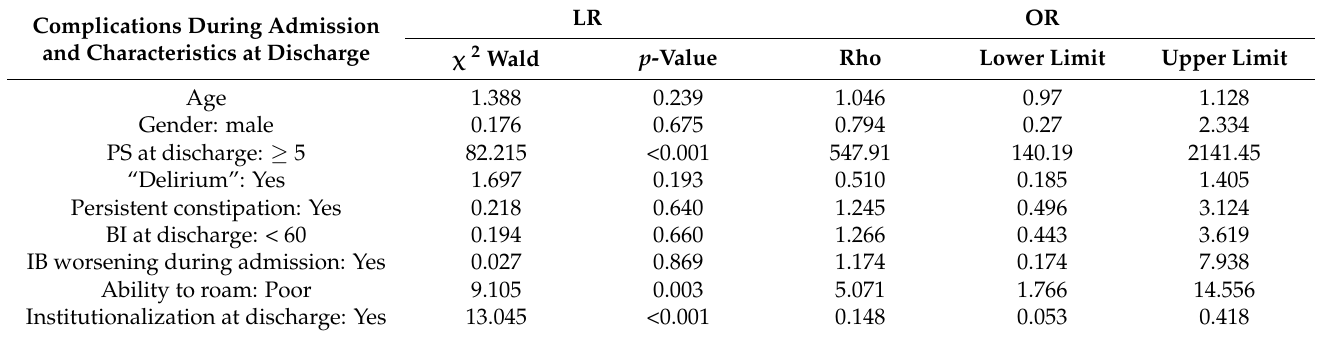
Table 4. Results of binary logistic regression to estimate the relationship between complications during admission and characteristics at discharge and cognitive impairment at the sixth month.